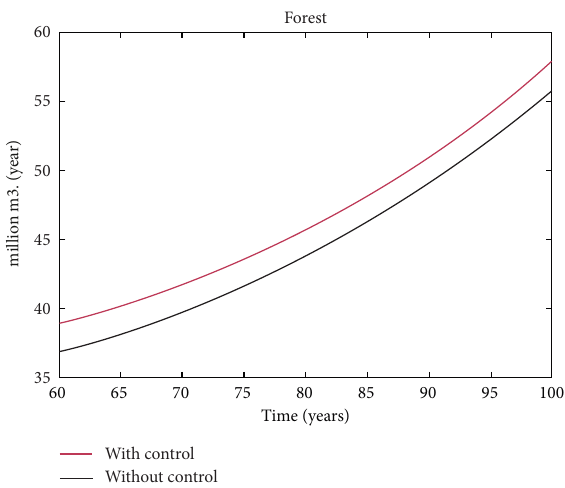
Figure 5: Optimal solutions for forest with and without control.